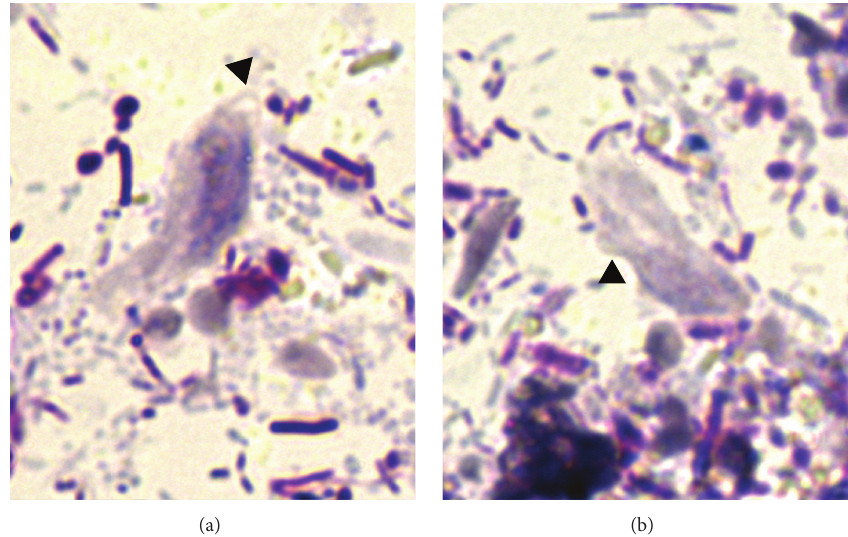
Figure2:Trichomonadsinfecalsmearfromthecatwithdiarrhea.Arrowheadsin(a)indicateanteriorflagellaemergingfromthetrophozoite, while arrow heads in (b) indicate undulating membrane